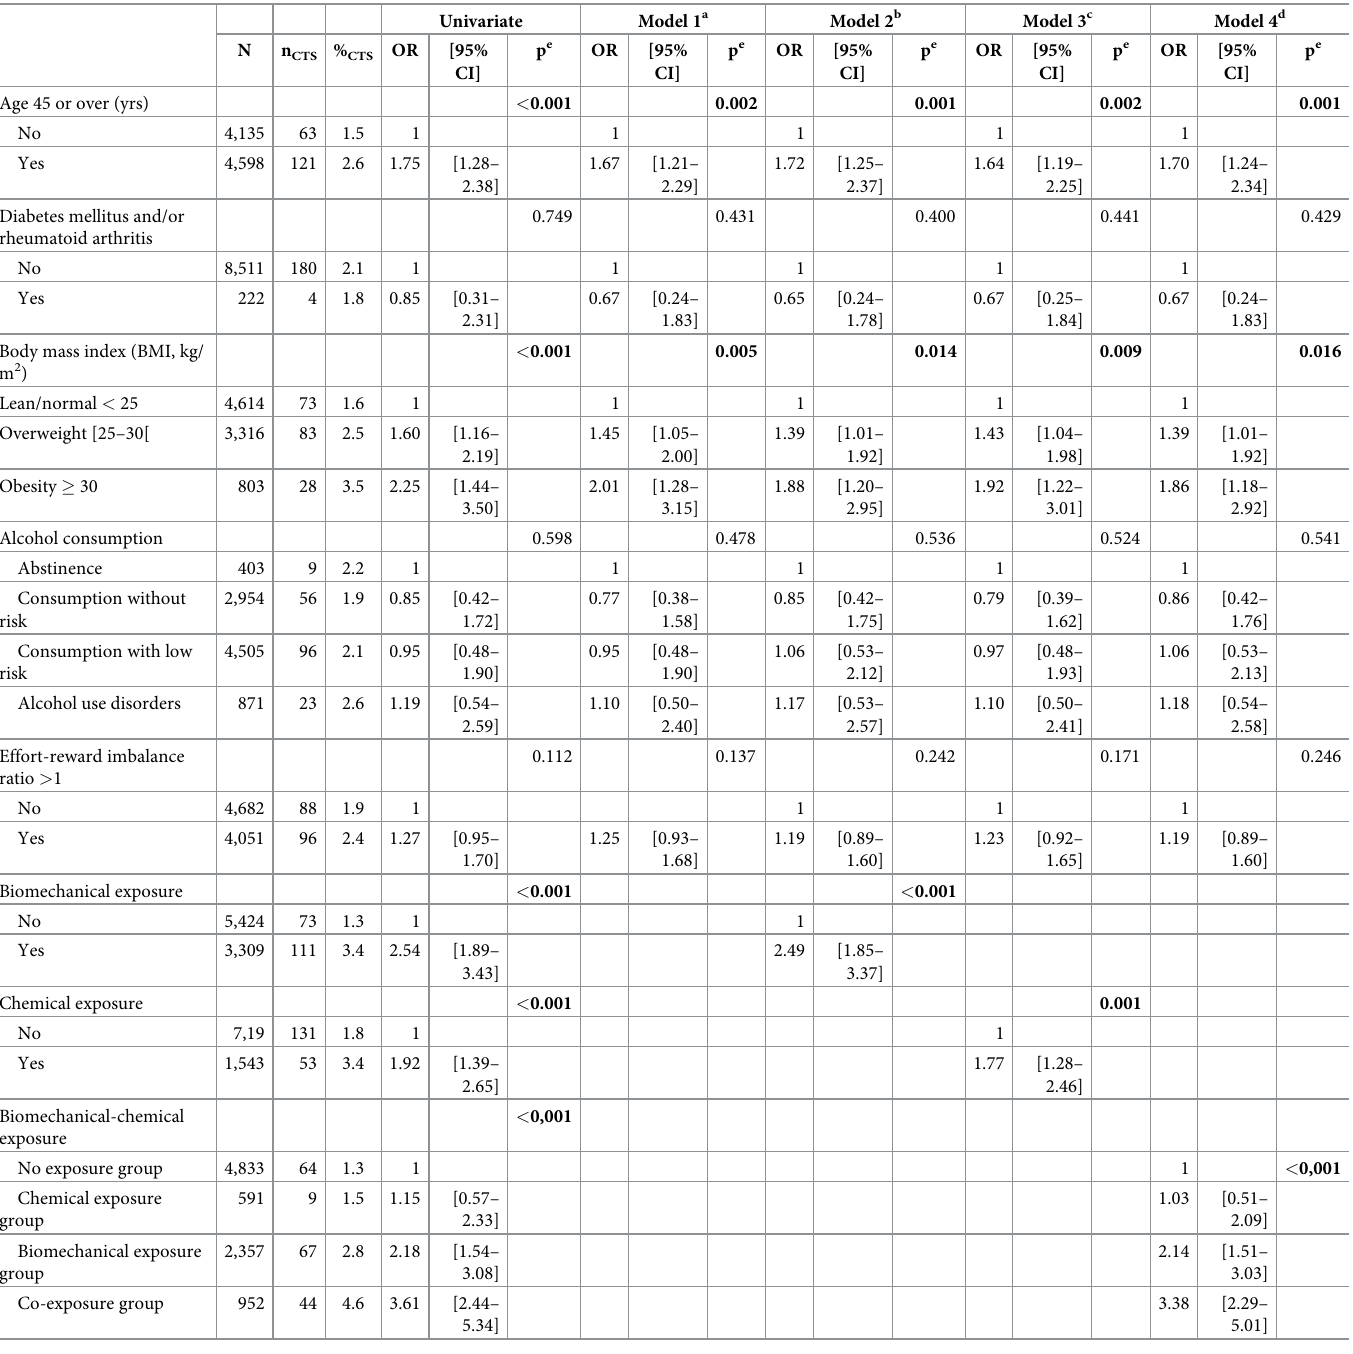
Table 2. Univariate and multivariate risk models for CTS in men (N =